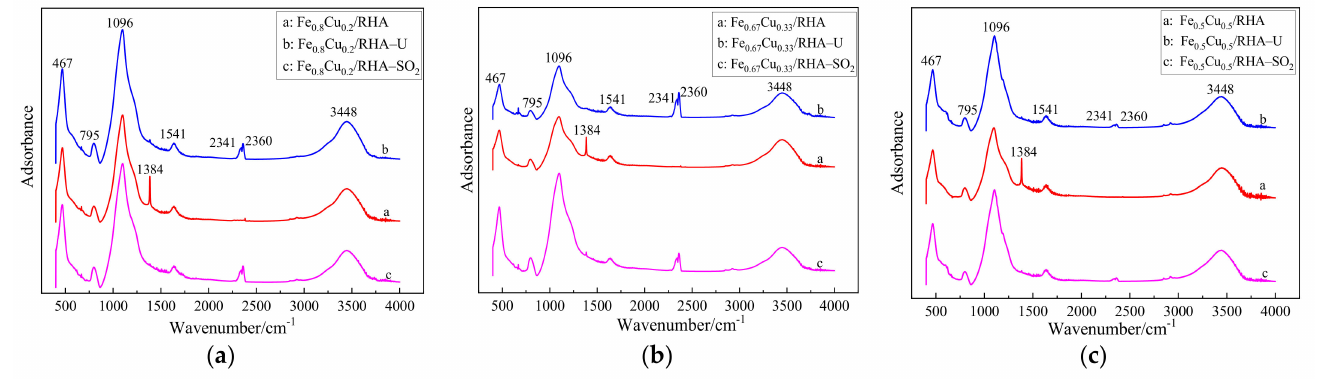
Figure 7. FTIR spectra of fresh catalysts, catalysts used, and catalysts after SO 2 resistance tests: ( a ) Fe 0.8 Cu 0.2 /RHA; ( b ) Fe 0.67 Cu 0.33 /RHA; ( c ) Fe 0.5 Cu 0.5